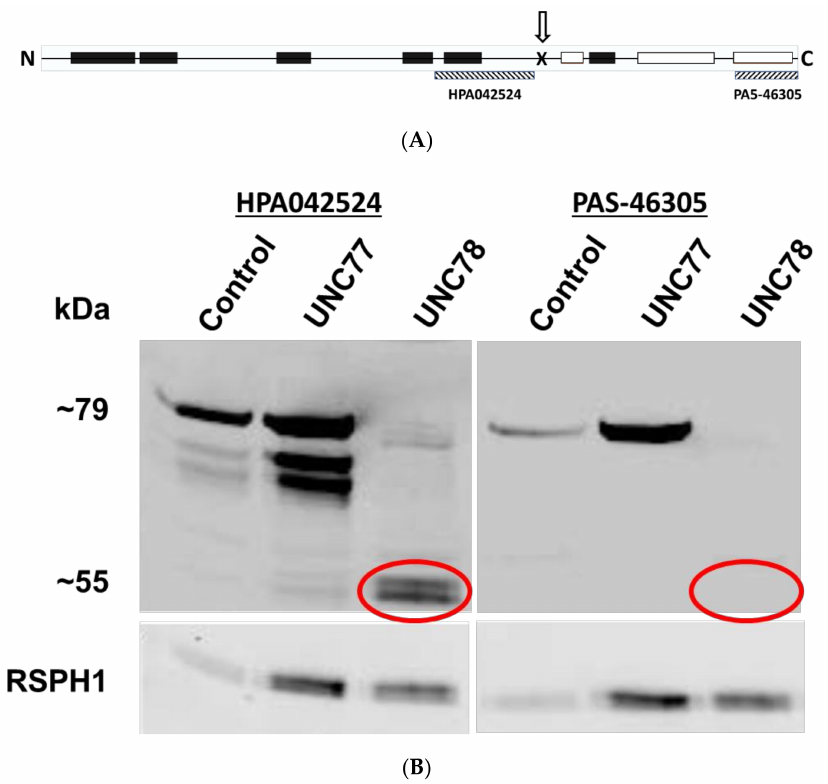
Figure 5. Western blotting of axonemal proteins. ( A ) Diagram showing the approximate location of the pSer469Argfs*7 mutation (arrow, X) and the antigenic site of the two antibodies used (hatched boxes). Predicted coiled–coil domains are shown in black boxes; disordered domains are shown as white boxes. ( B ) Cilia were isolated from ALI cultures of control, UNC77, and UNC78 cells and analyzed by Western blotting using two different ODAD1 antisera. Antisera against the mid-region of ODAD1 recognizes two truncated proteins in the sample from UNC78 (left), while the antisera against the C-terminus does not recognize these proteins